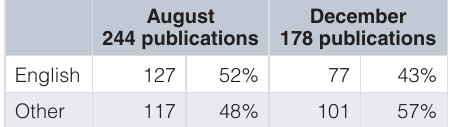
Table 6b. Language of publications with UID exported from Pure to SciVal and not matched.